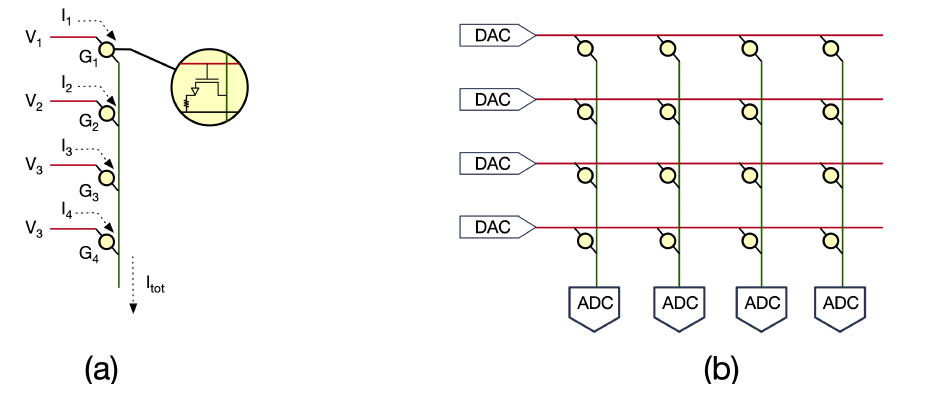
Figure 2. ( a ) A ReRAM column. ( b ) ReRAM